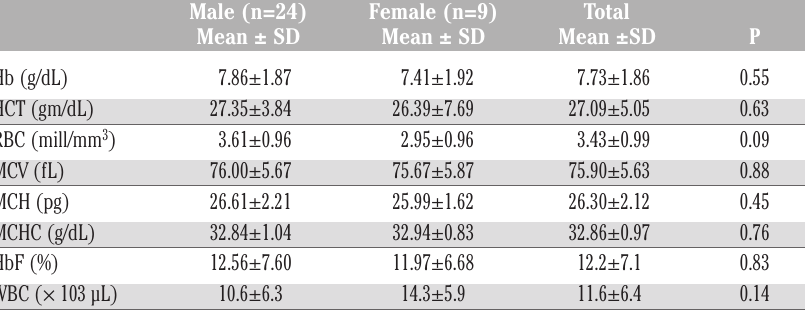
Table 1. Hematological comparison between male and female sickle cell patients